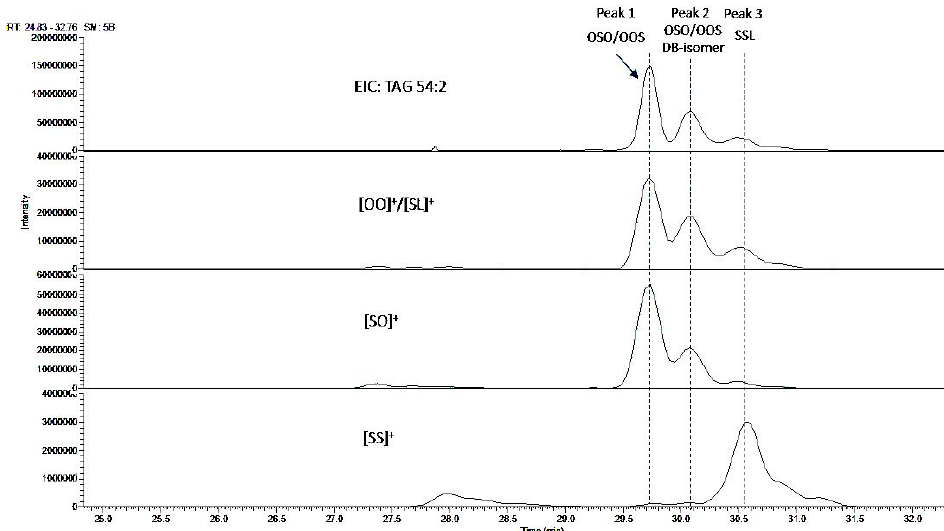
Figure 4. LC-MS (EIC) profile of TAG 54:2. Alignment of the parent ion ( m / z 904.8) with the fragment ions m / z 603.5 ([OO] + or [SL] + ), 605.5 ([SO] + ), and 607.5 ([SS] + ) allowing assignment of the three peaks as OSO/OOS mixture (Peak 1), OSO/OOS DB-isomers (Peak 2), and SSL (Peak 3); noting the presence of isobaric fragment ions [OO] + and [SL] + for this TAG group. L: linoleic acid; O: oleic acid; S: stearic acid.